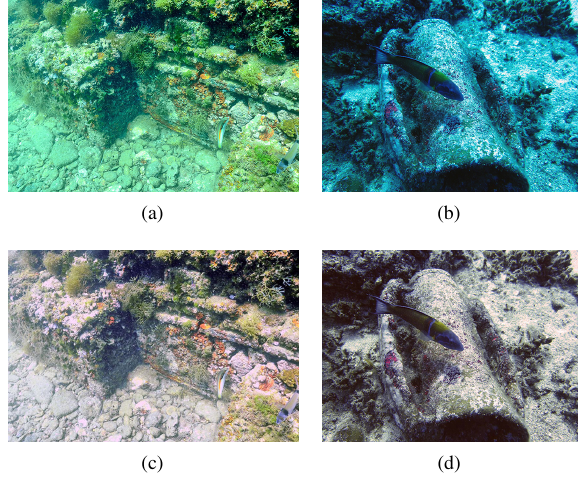
Figure 4: Two cases of underwater images analysed in this work (a), (b), and the relative results obtained with our algorithm (c), (d).